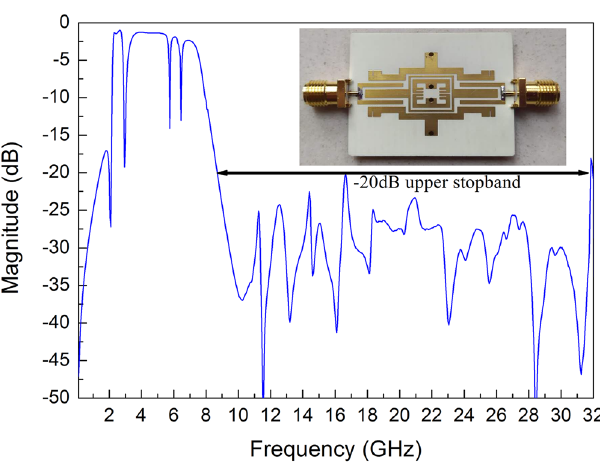
Figure 2. The proposed tri-notched wideband filter with ultrawide upper stopband up to 32